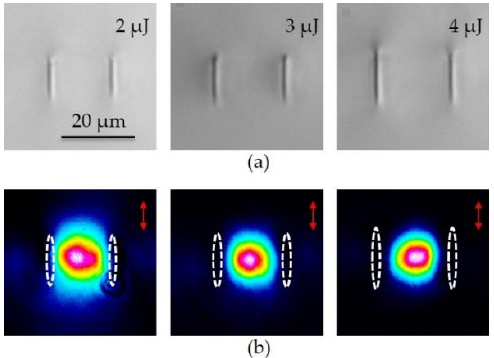
Figure 7. ( a ) Cross-section of the waveguide tracks and ( b ) near-field fluence maps of the guided modes at the three input energy values of 2 µ J, 3 µ J, and 4 µ J.